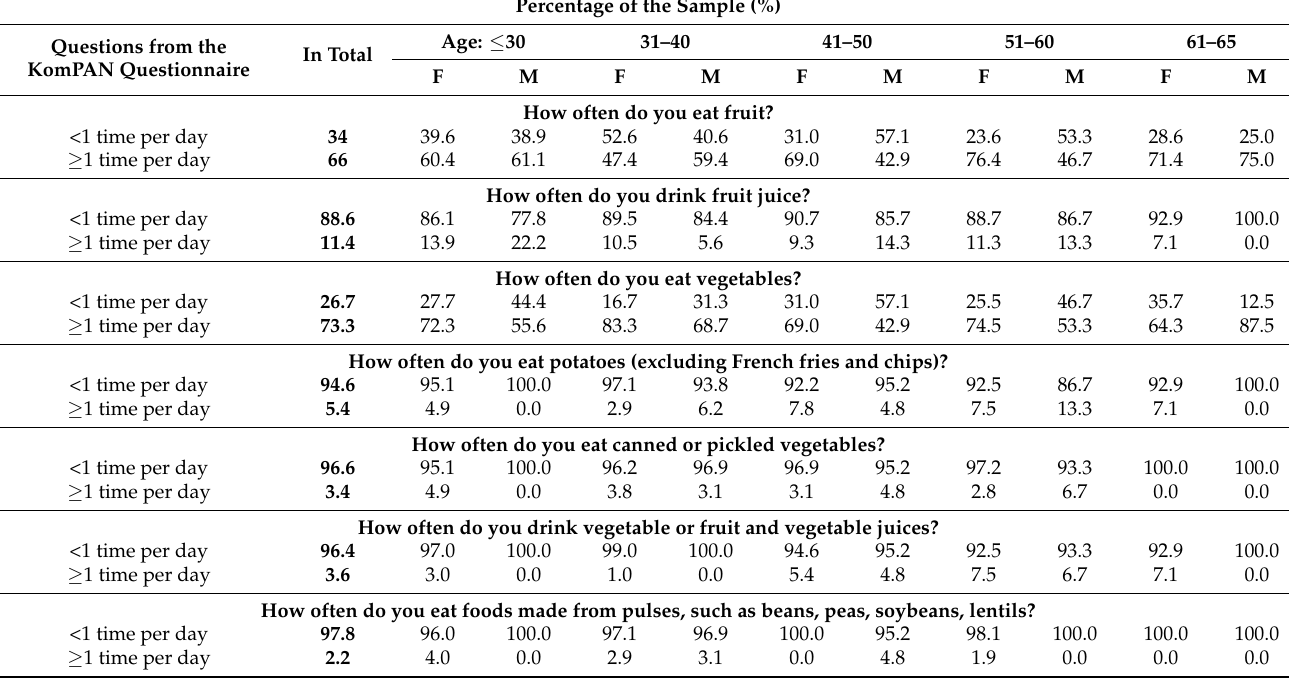
Table 3. Fruit and vegetable intake among Polish pharmacists ( n = 667) Abbreviations: F, females.